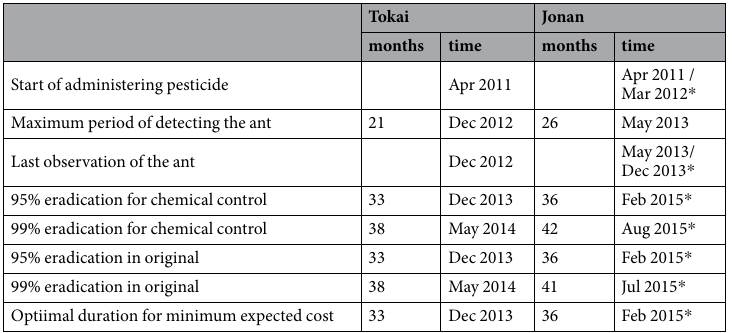
Table 1. Month and time details in the eradication program of Argentine ants. * A plot of Jonan (Plot I) where administering pesticide was late due to another